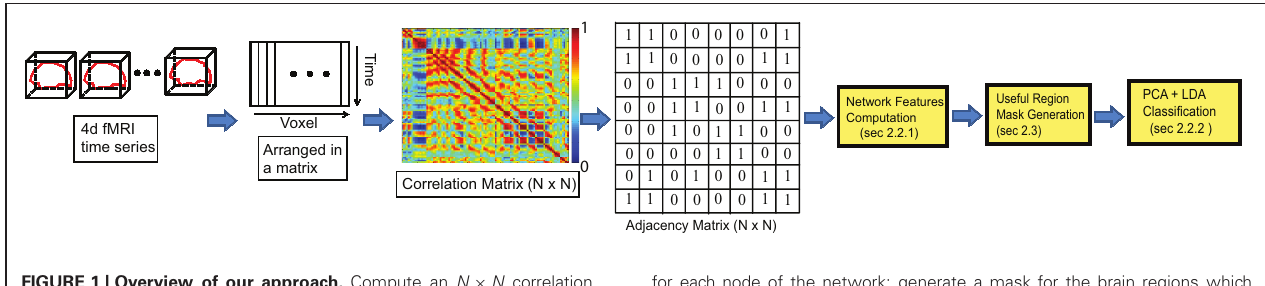
FIGURE 1 | Overview of our approach. Compute an N × N correlation matrix ( N is the number of voxels) using fMRI data; compute the adjacency matrix by thresholding the low correlation values to generate a network; compute network features such as node degree and cycle count